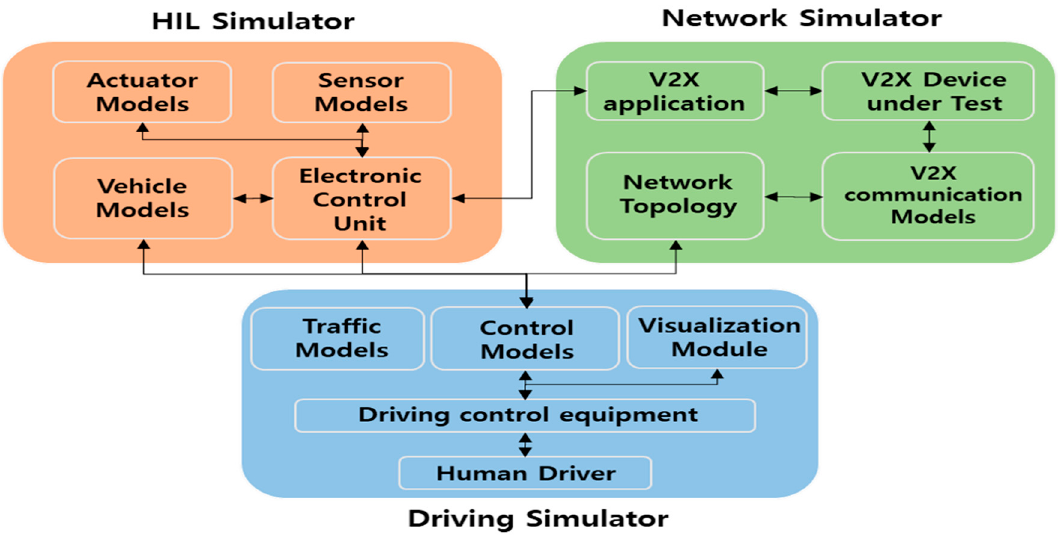
Figure 1. Architecture of IDHIL simulator.